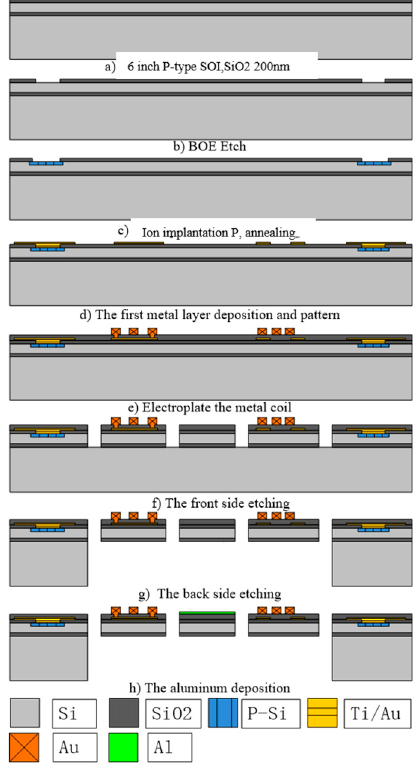
Figure 6. Fabrication process of the mirror.